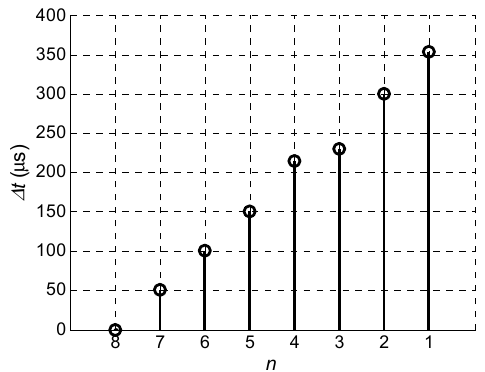
Figure 28. Experimentally obtained optimised delay scheme. Sensors 2018 , 18 , x FOR PEER REVIEW